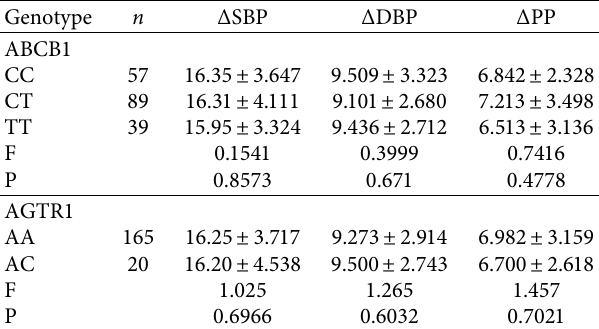
Table 4: Each genotype patient’s blood pressure